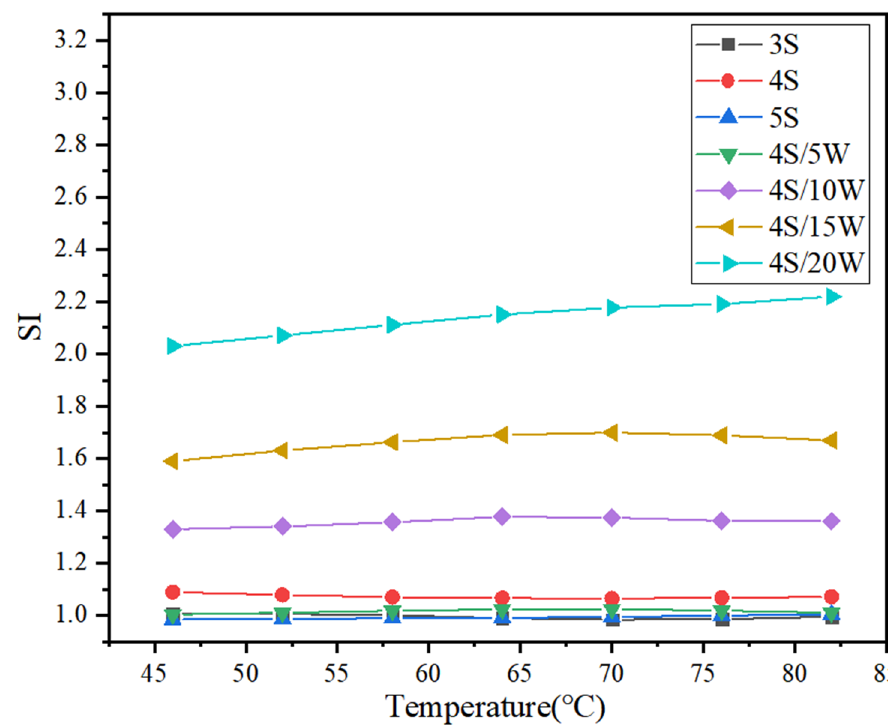
Figure 11. Segregation of G * /sin δ at top and bottom samples of WPU/SBS composite modified asphalt.